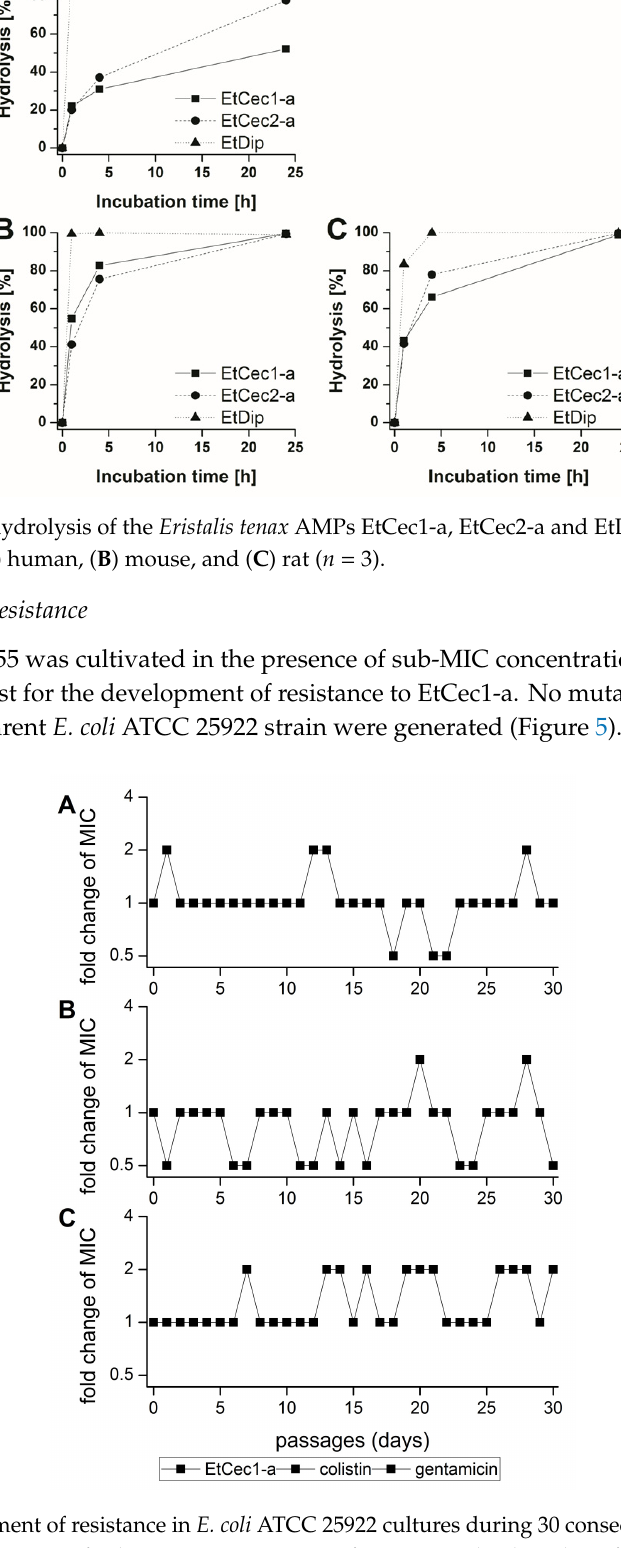
Figure 5. Development of resistance in E. coli ATCC 25922 cultures during 30 consecutive days of serial passaging in the presence of sub-MIC concentrations of EtCec1-a. The data show fold-changes in MIC for ( A ) EtCec1-a, ( B ) colistin, and ( C ) gentamicin ( n = 3).